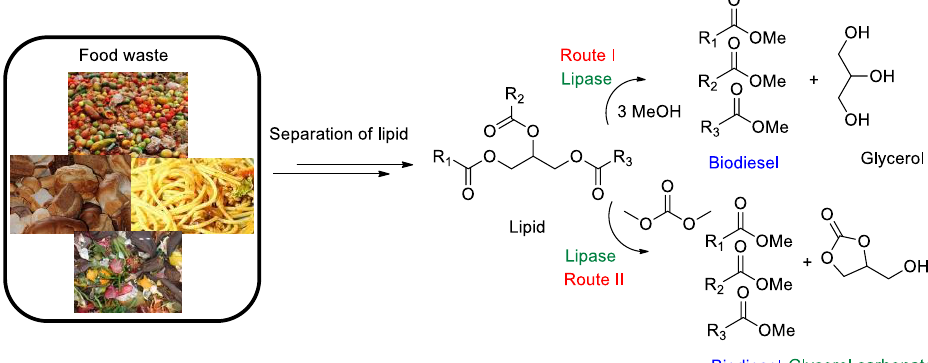
(Figure 11, route I) [36]. The lipid was obtained via enzymatic hydrolysis of food waste. The obtained lipid was reacted with methanol (lipid to methanol molar ratio: 1:5) using Novozym 435 as a catalyst. Under optimized reaction conditions, the immobilized lipase gave 90% biodiesel in 24 h at 40 ◦ C [36].